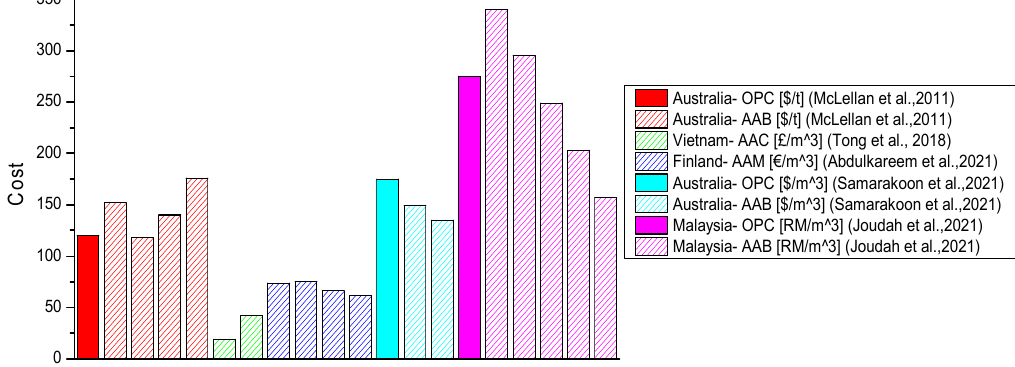
Figure 9. Economic performance of alkali-activated materials [8,10,114,145,146].